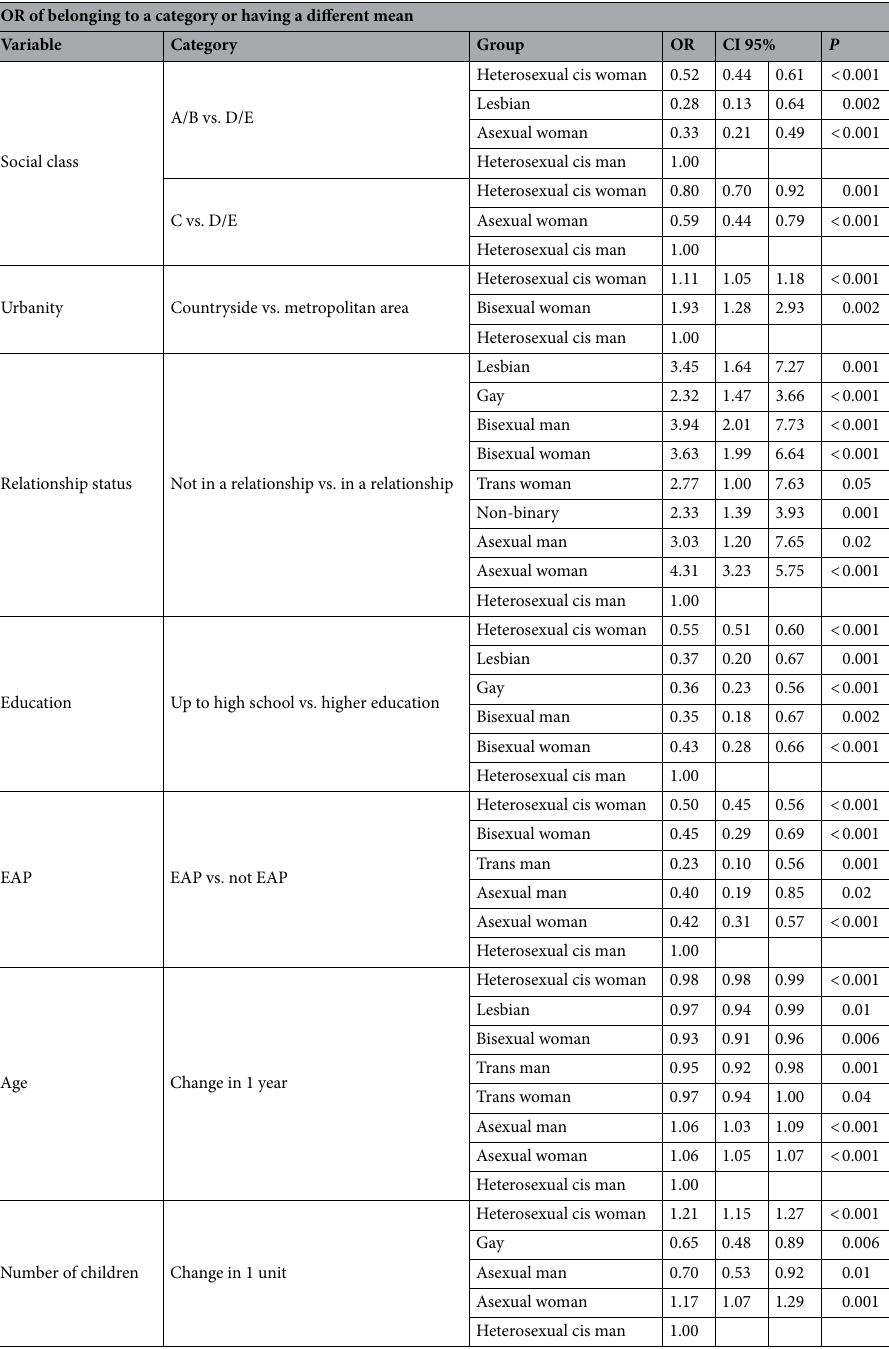
Table 1. Predictive effect of group on sociodemographic characteristics. OR odds ratio, CI confidence interval, EAP economically active population. Only statistically significant comparisons are reported.